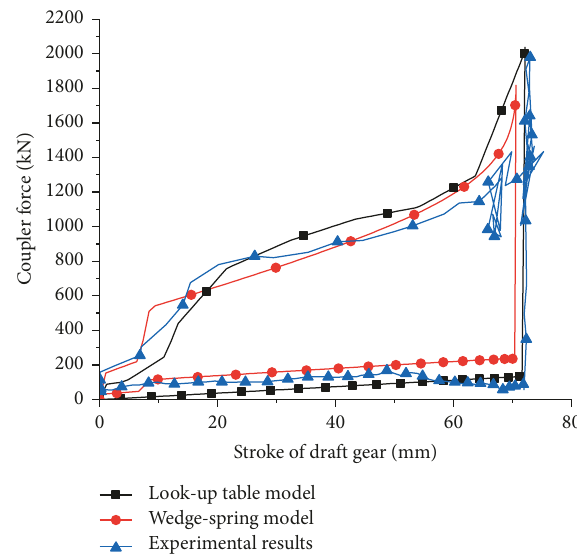
Figure 5: Simulation results of the two models and comparison of experimental